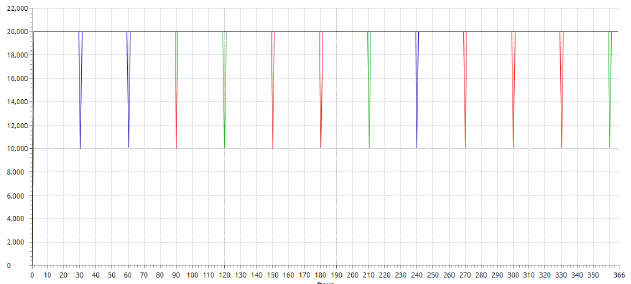
Figure 21. Available Inventory of Scenario II.